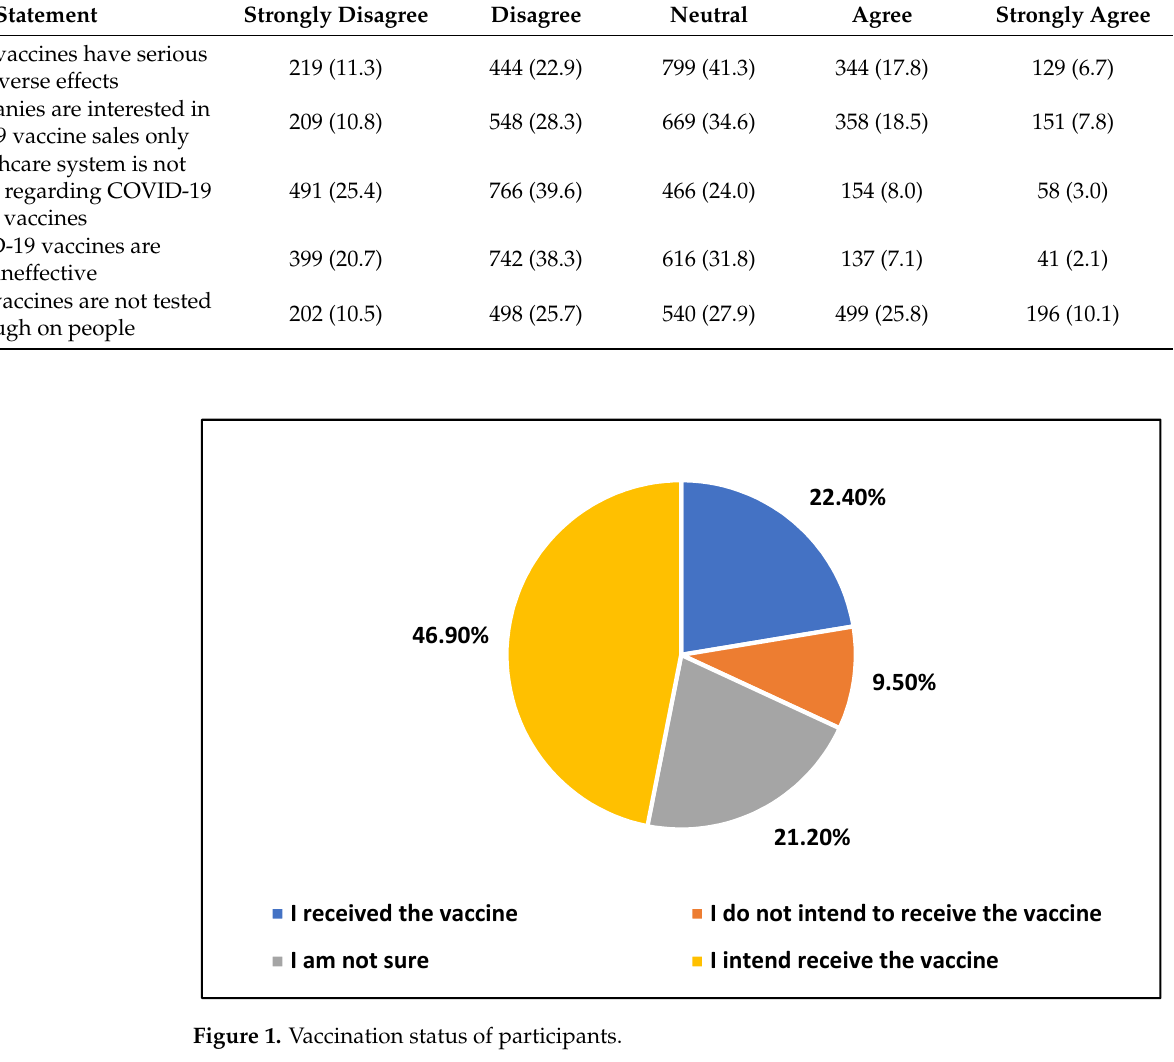
Table 3. Concerns of participants about COVID-19 vaccines.